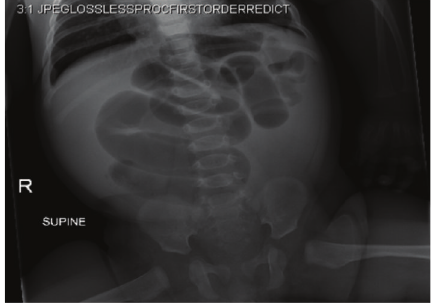
Figure 3: Supine abdominal plain